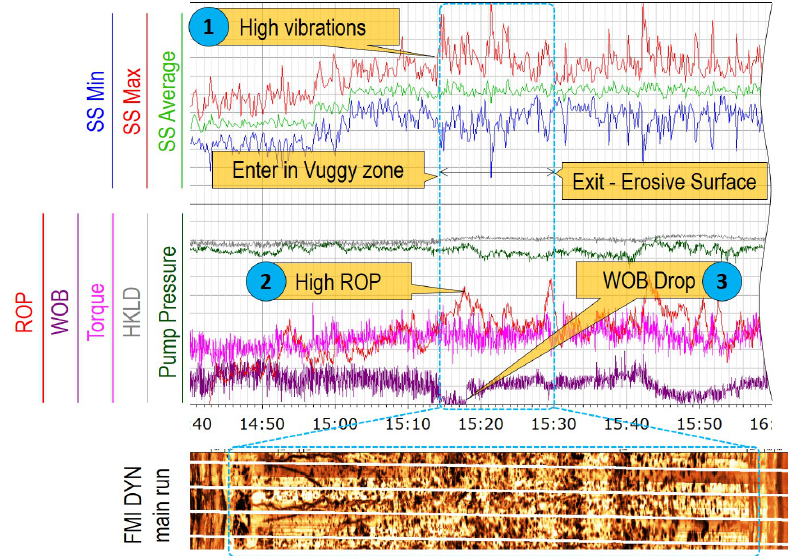
Figure 8. Drilling mechanics data in the 6 m (19.7 ft)interval of vugs 6 m thickness (Well